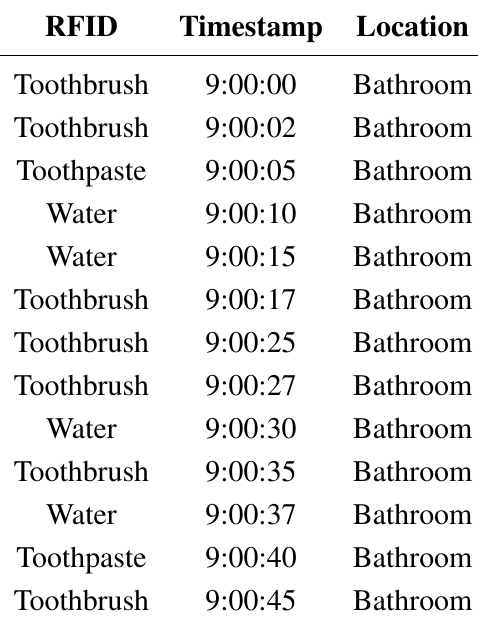
Table 1. Measurement registered with our RFID-watch during the execution of the brushing teeth